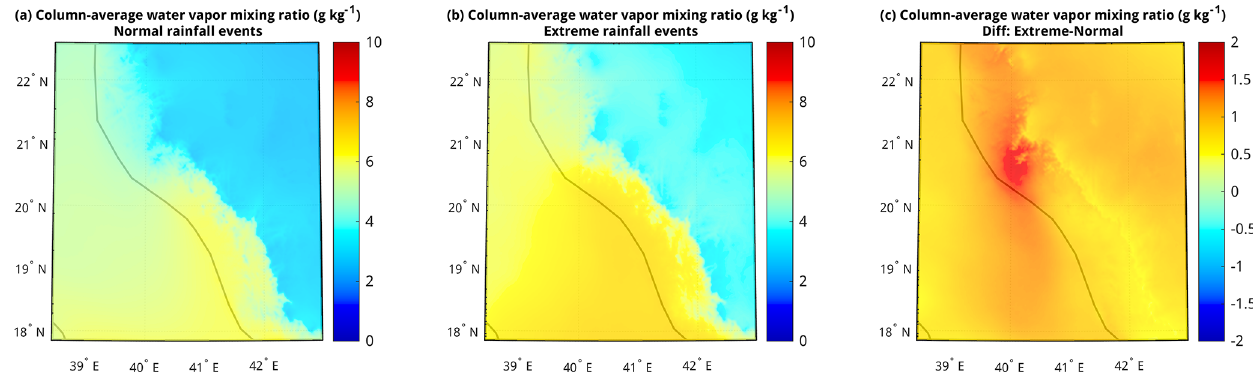
Figure 16. Column-average water vapor mixing ratio for (a) normal rainfall events, (b) extreme rainfall events, and (c) the difference in extreme and normal rainfall